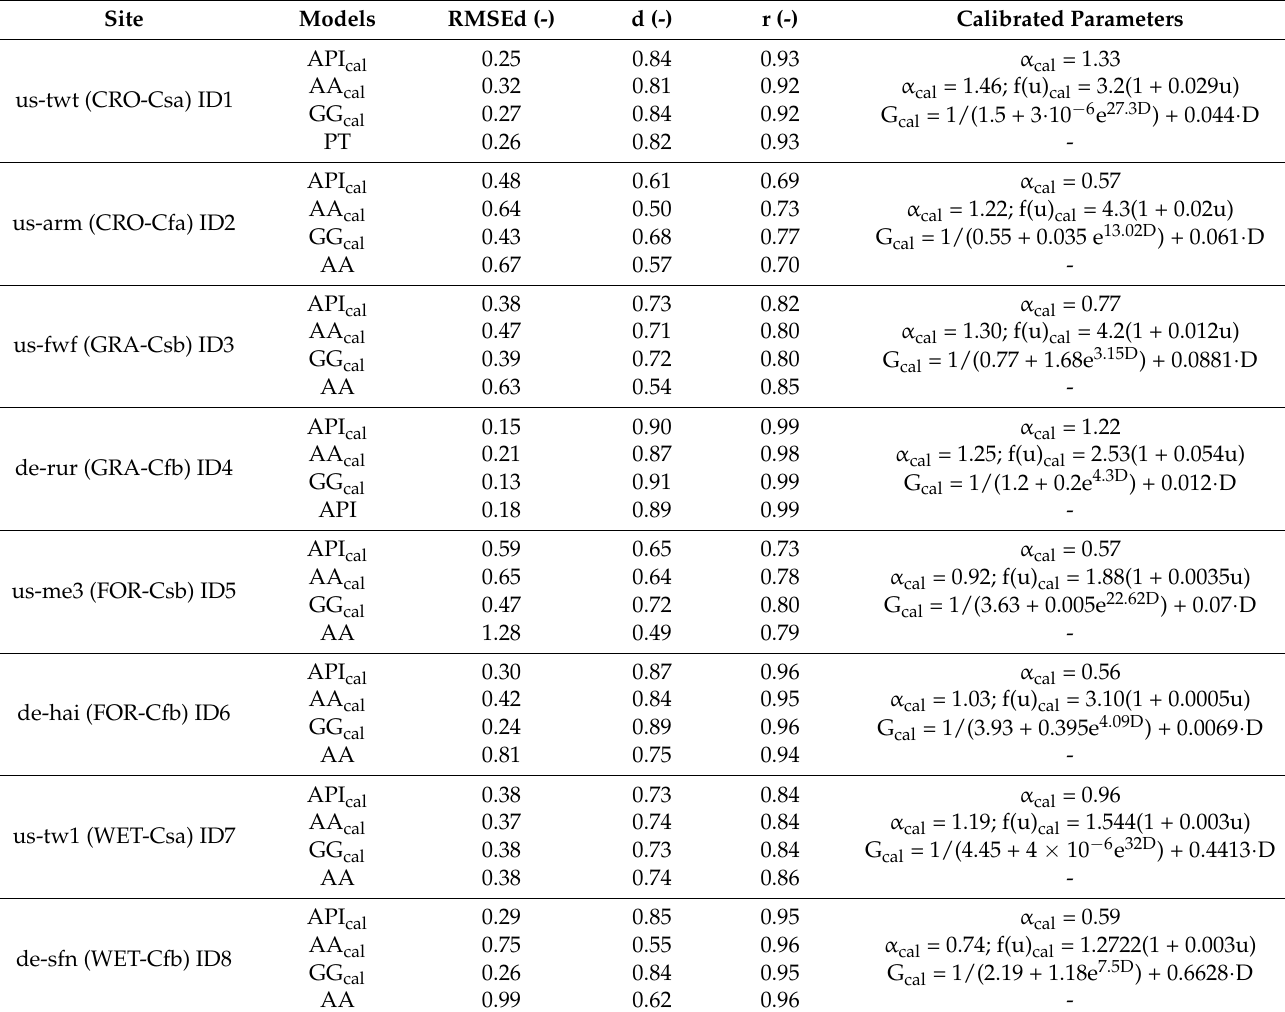
Table 7. Goodness of fit indices for the eight experimental sites. The most accurate models in case of calibrated and non-calibrated approach are compared (Table